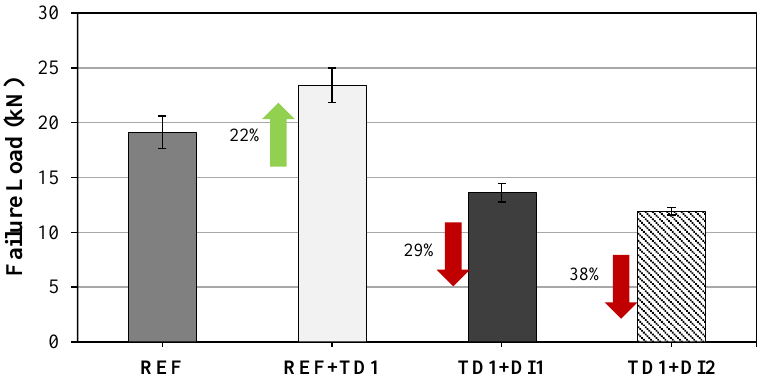
Figure 6. Tensile failure load presented for each contamination scenario.